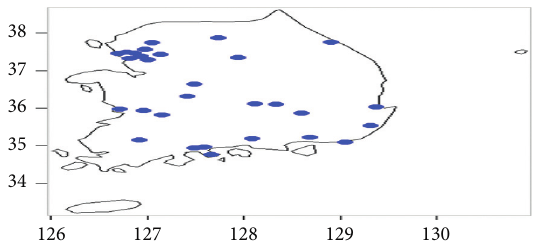
Figure 1: The distribution of the selected 29 air monitoring sites in South